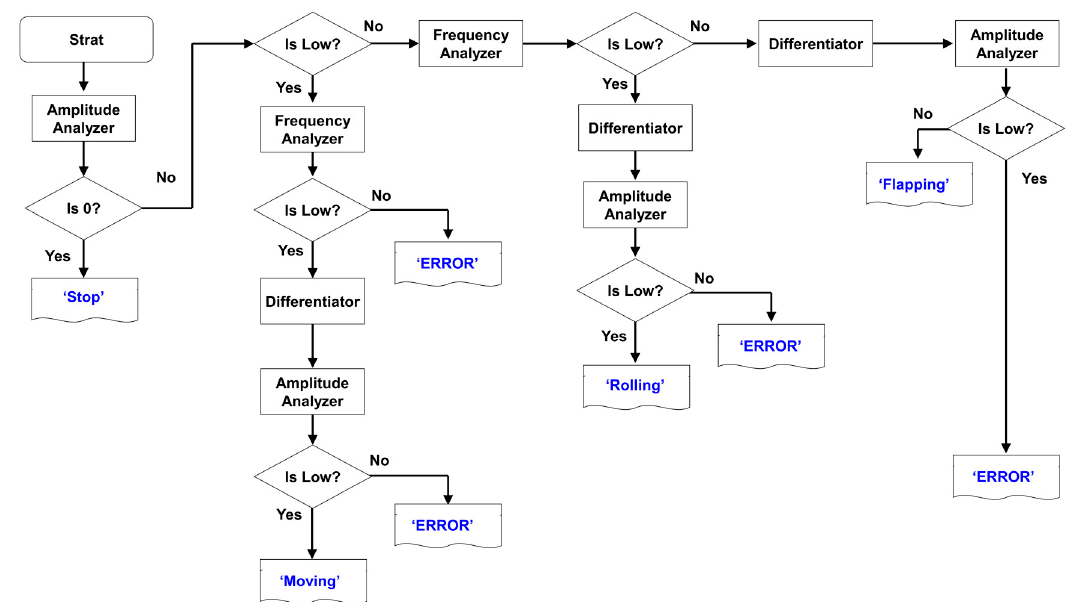
Figure 10. Proposed analysis algorithm with 4 functions: ’Frequency Analyzer’, ’Amplitude analyzer’, ‘Differentiator’, ‘Is Low?’. The ‘is Low?’ function has two input as analyzer output and analyzer type. During the execution of evlaution for the algorithm, the ‘Is Low?’, next to ’Frequency analyzer’, identifies if the input is greater than 1. Table 2. Summary of criteria on identification for the function of ‘Is Low?’ in terms of frequency, amplitude, and amplitude for the signal of ‘derivative of amplitude (dV/dt)’.